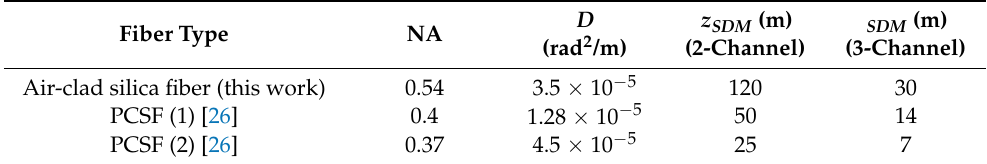
Figure 4. Normalized output intensity at different lengths of the multimode SI air-clad silica optical fiber obtained as solutions of Equation (2) for D = 3.5 × 10 −5 rad 2 /m, two launch beams in the Gaussian form, and input angles θ 0 = 0 ◦ (solid line) and 26 ◦ (dotted line), with (FWHM) z=0 = 3.9 ◦ for: ( a ) z = 40 m and ( b ) z = 120 m. Table 1. Length z SDM for two and three spatially multiplexed channels with minimal crosstalk in SI air-clad silica optical fibers and PCSFs, with different numerical apertures NA and coupling coefficients D